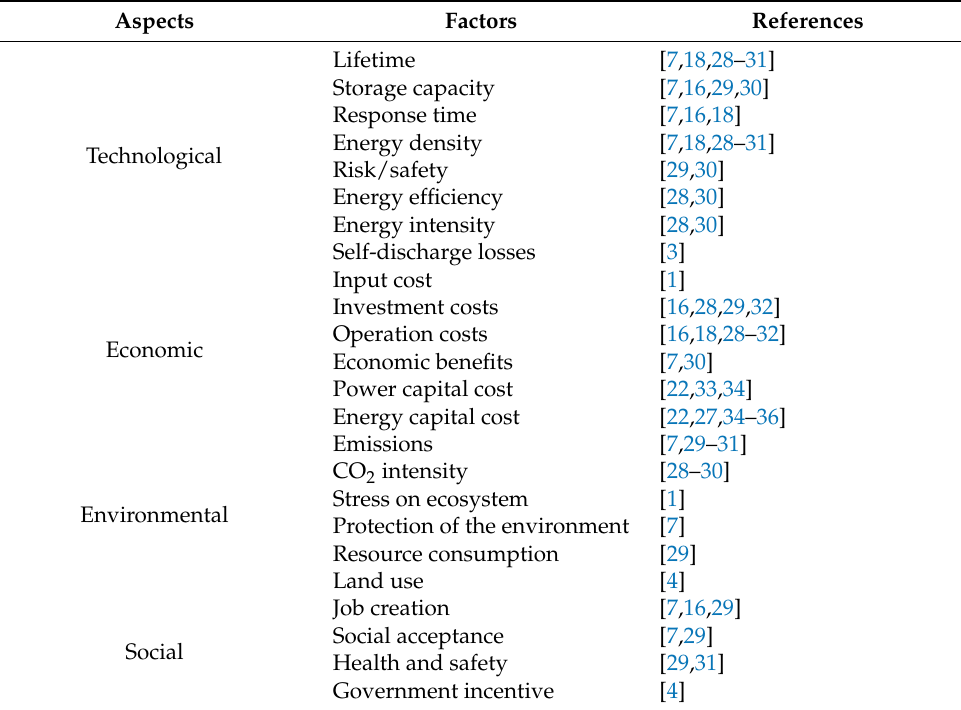
Table 1. Evaluation criteria for energy storage technologies and the literature